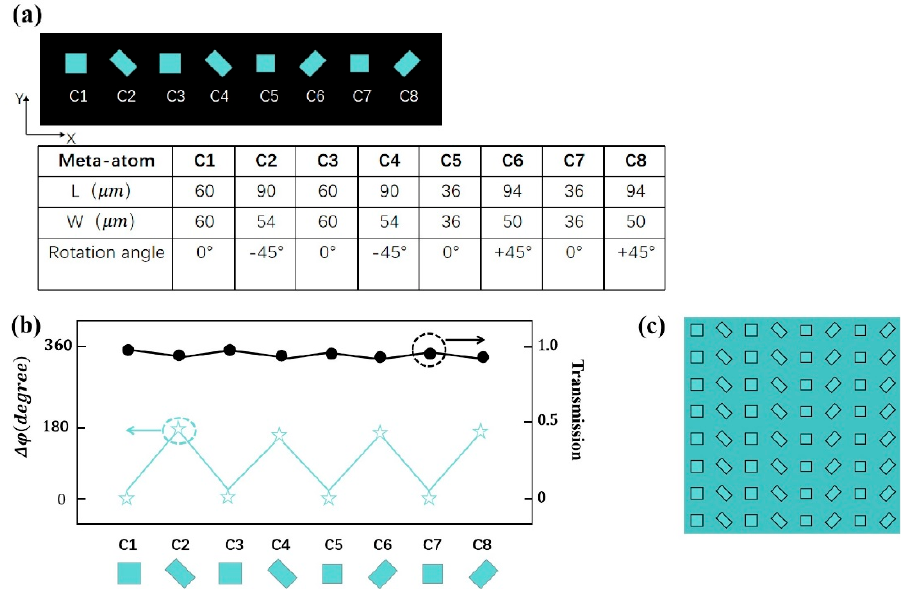
Figure 3. Eight meta − atoms (silicon dielectric pillars): ( a ) dimensional parameters of 8 dielectric pillars ( b ) transmission (black dots) and phase difference between x − and y − axes (pentagram); ( c ) full dielectric top view of the metasurface.